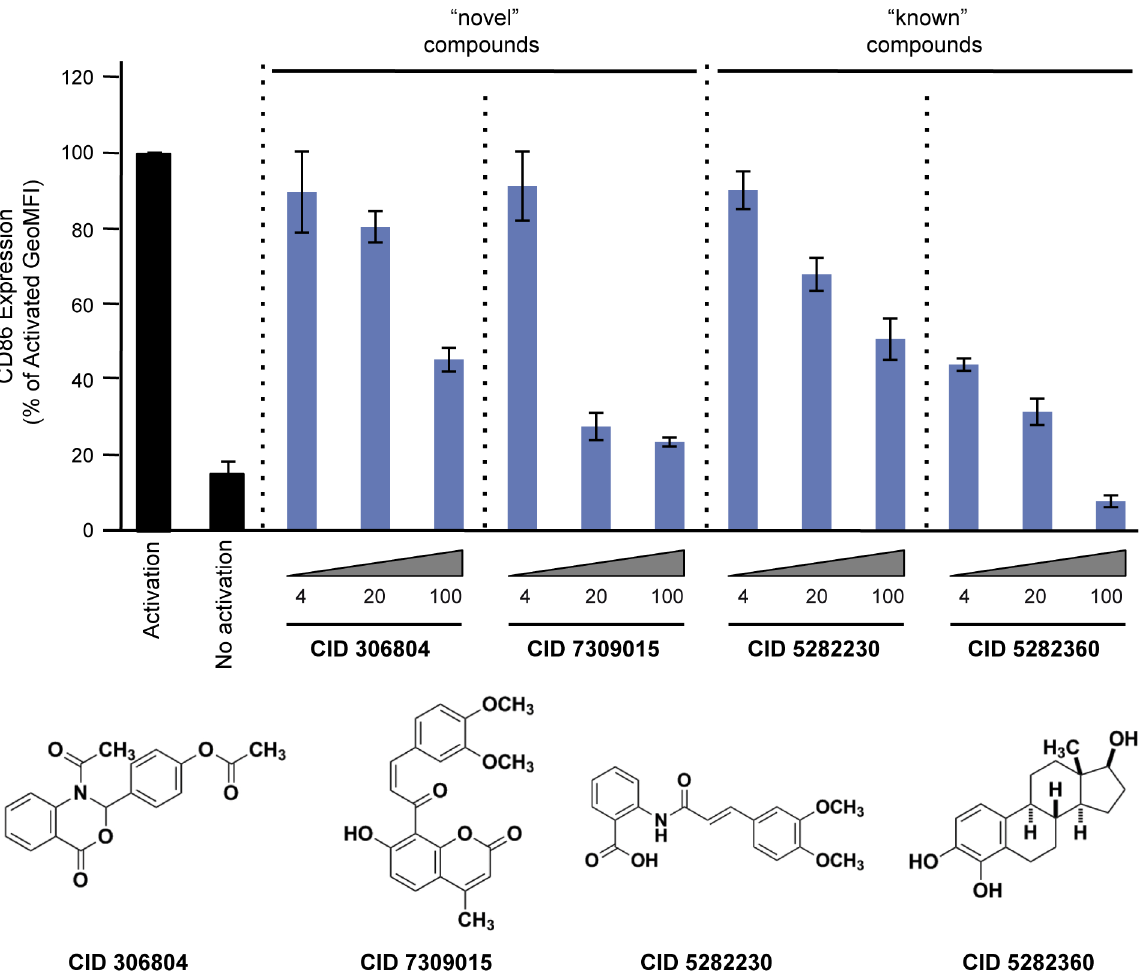
Figure 4. Effect of compounds on CD86 expression in primary CD19 + B cells. Purified human CD19 + primary B cells were incubated with 10 ng/ml IL4 alone (‘‘No activation’’) or IL4 + 64 ng/ml tCD40L (‘‘Activation’’), together with different concentrations of drugs for 48 hours. CD86 expression was measured by PE GeoMFI on CD19 + gated B cells. The chemical structure of each compound is shown.